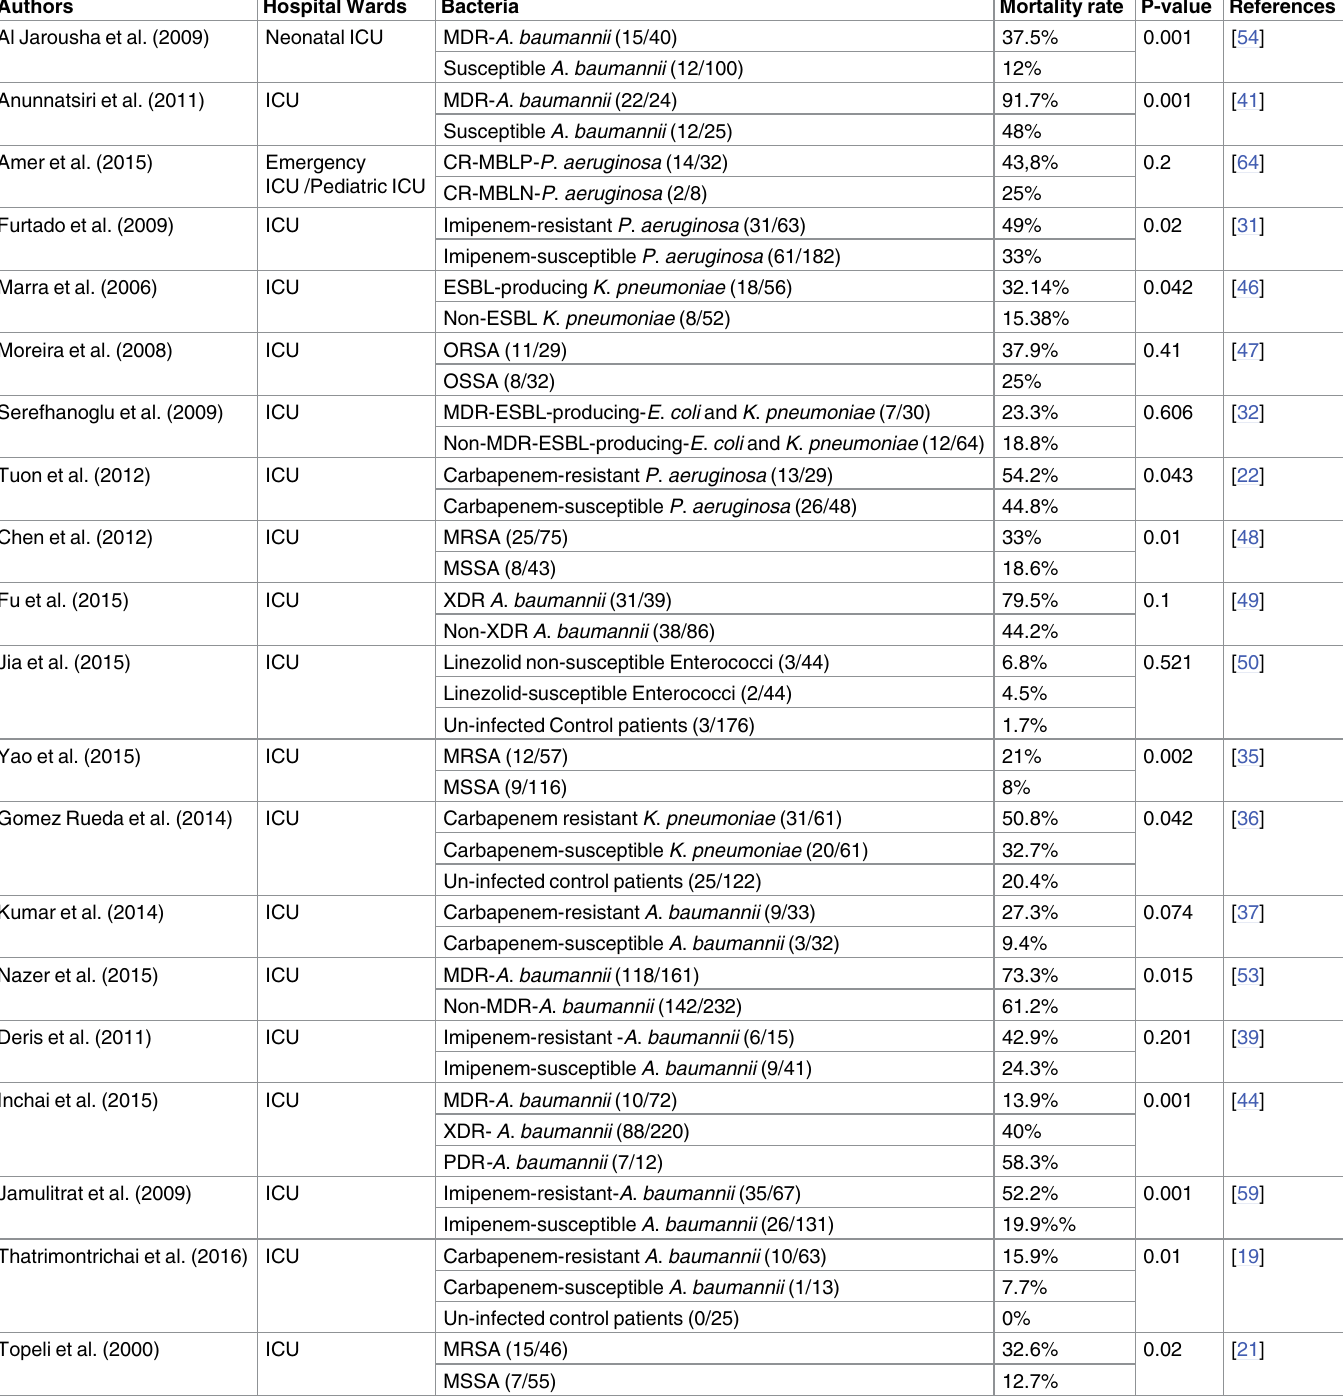
Table 3. Studies describing mortality rate associated with resistant and MDR ESKAPE